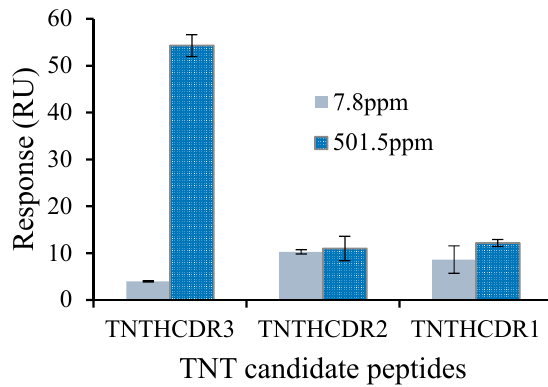
Figure 2. Screening TNT binding peptide among candidate peptides TNTHCDR1, TNTHCDR, and TNTHCDR3 using an APTES-based chip. The error bar indicates the calculated standard deviation ( n = 3). RU: resonance units.